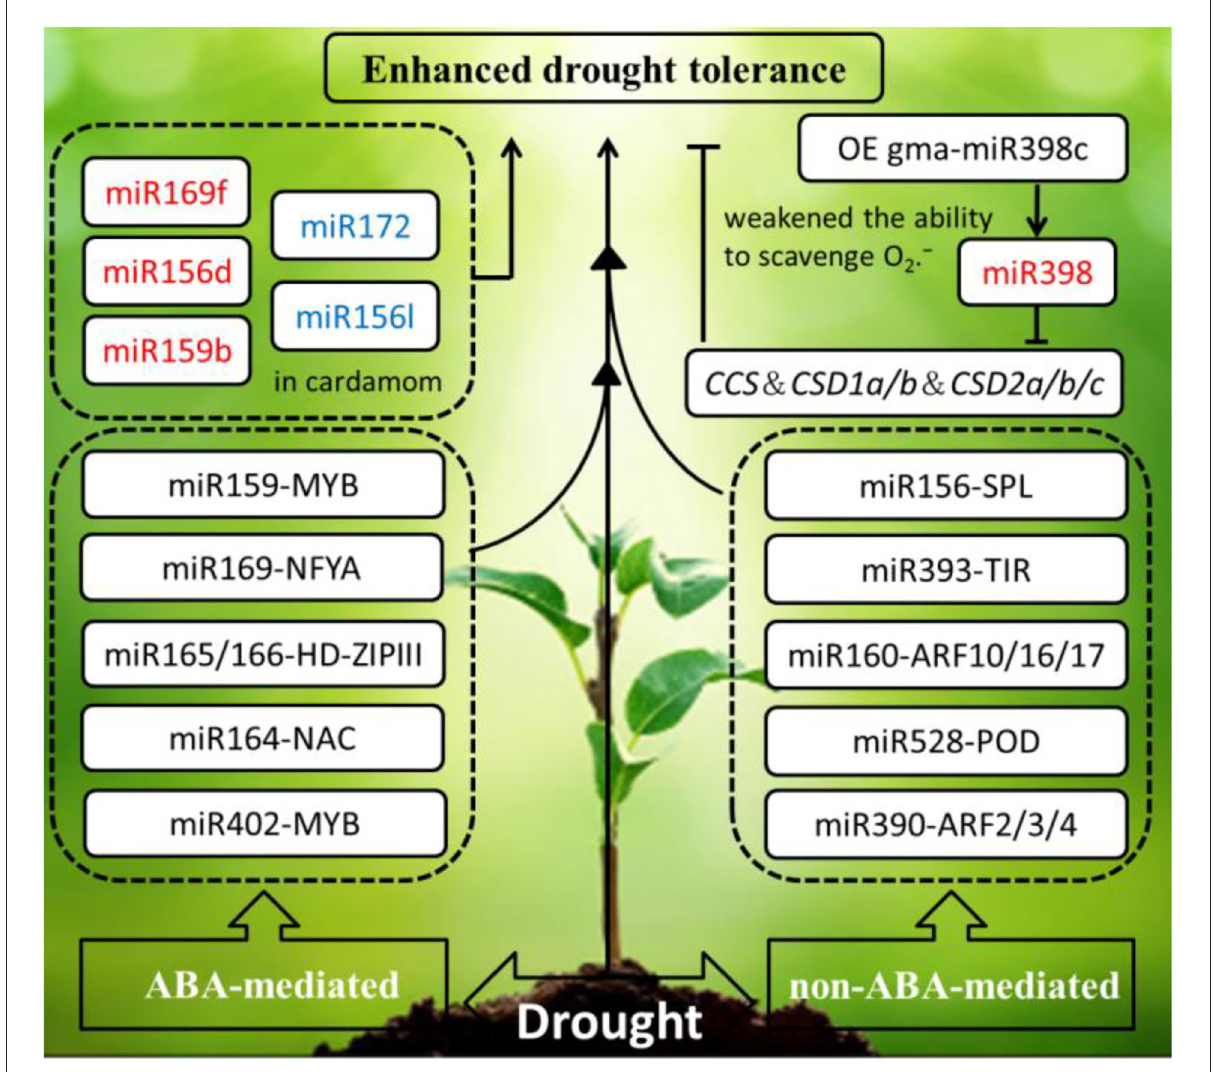
FIGURE3 Schematic diagram of the drought-responsive miRNAs in plants are primarily by phytohormone ABA-mediated and non-ABA-mediated pathways initiating an adaptive response to enhance drought tolerance. The miRNAs in red and blue font were upregulated and downregulated under drought stress, respectively. The arrows and hammer represent positive and negative regulation, respectively. OE, overexpression; MYB, MYB proto-oncogene transcription factor; NF-YA, nuclear factor Y subunit A; HD-ZIPIII, zipper motif (LZ) immediately downstream of the home domain; NAC, NAM, ATAF, and CUC (NAC) transcription factors; CCS, copper chaperone for superoxide dismutase; CSD, copper-zinc superoxide dismutase 1and 2; SPL/SBP, SQUAMOSA promoter-binding proteins; TIR, transport inhibitor response; ARF, auxin response factors; POD, peroxidase; ABA, abscisic